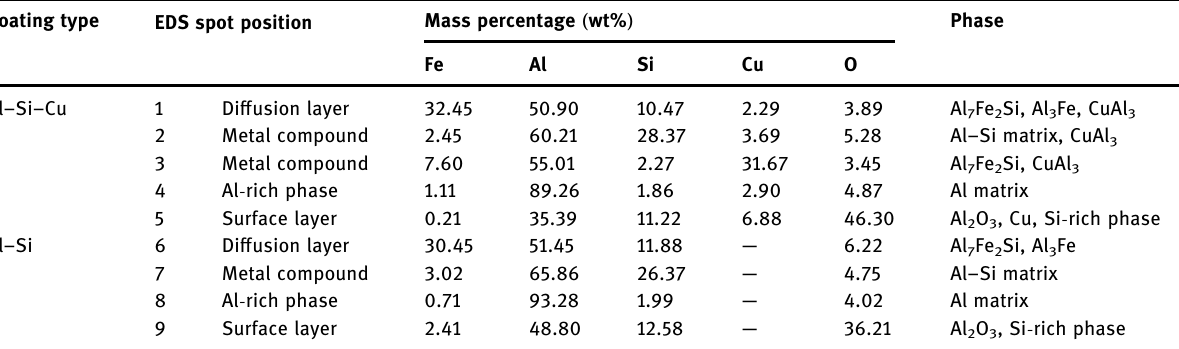
Table 7: EDS spot analysis of hot - dip coatings in Figure 10 Coating type